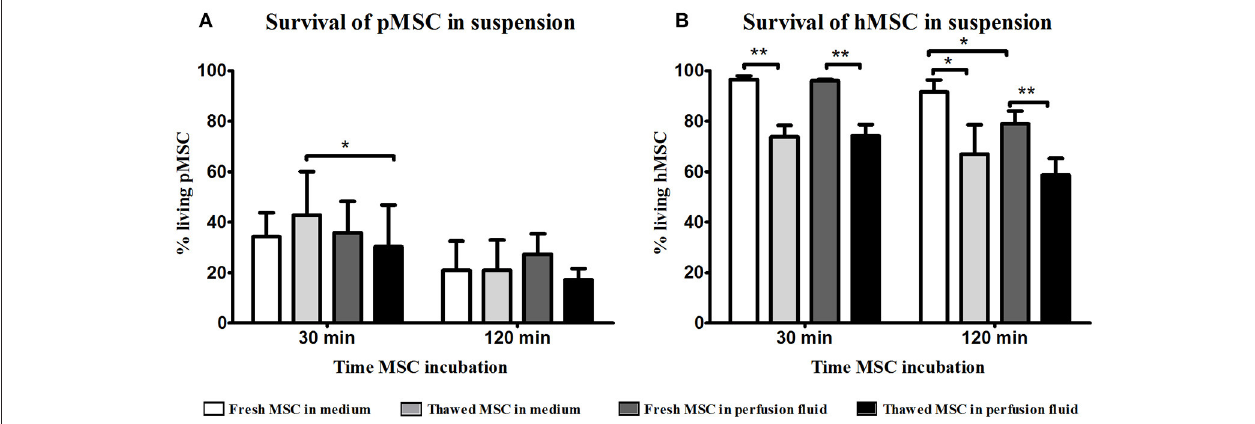
FIGURE 1 | Effect of perfusion fluid on survival of fresh and thawed pMSC and hMSC in suspension. (A) Perfusion fluid had minimal effect on pMSC survival compared to medium. (B) Perfusion fluid had minimal effects on hMSC survival. Thawed hMSC showed a lower survival in suspension compared to fresh hMSC. Perfusion fluid reduced survival of hMSC after 2h ( n = 5). Results are shown as means ± SD. * p < 0.05; ** p < 0.01.